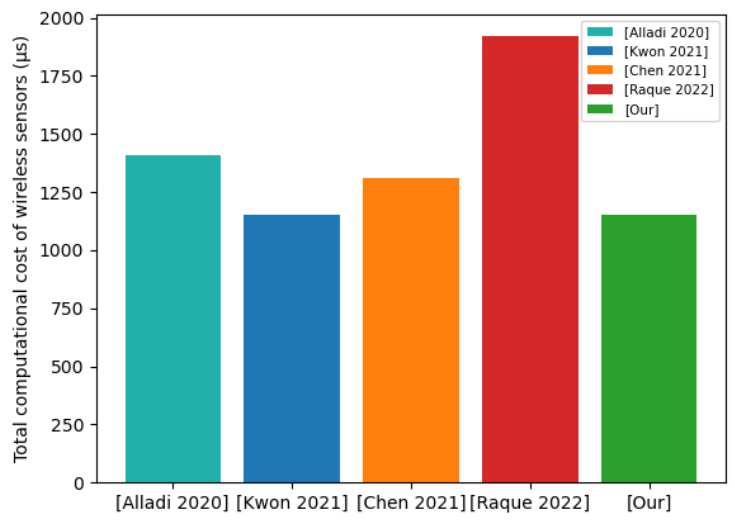
Figure 6. Communication cost of wireless